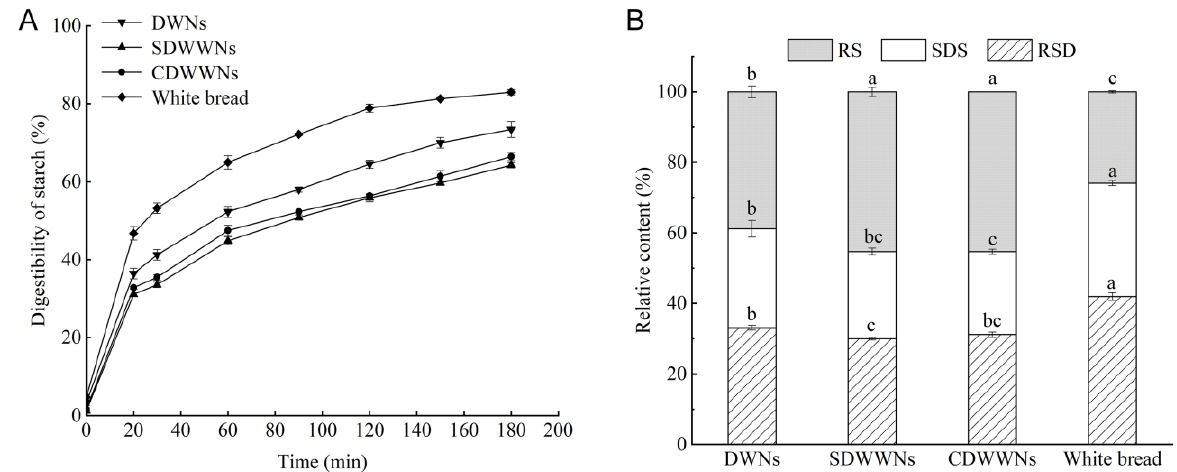
Figure 5. ( A ) Digestion progress curves of the cooked noodles; ( B ) The contents of the RDS, SDS, and RS of the cooked noodles. DWNs, dried wheat noodles; SDWWNs, stone-milled dried whole wheat noodles; CDWWNs, commercially dried whole wheat noodles. Different letters indicate significant differences in the same indicator data ( p < 0.05).